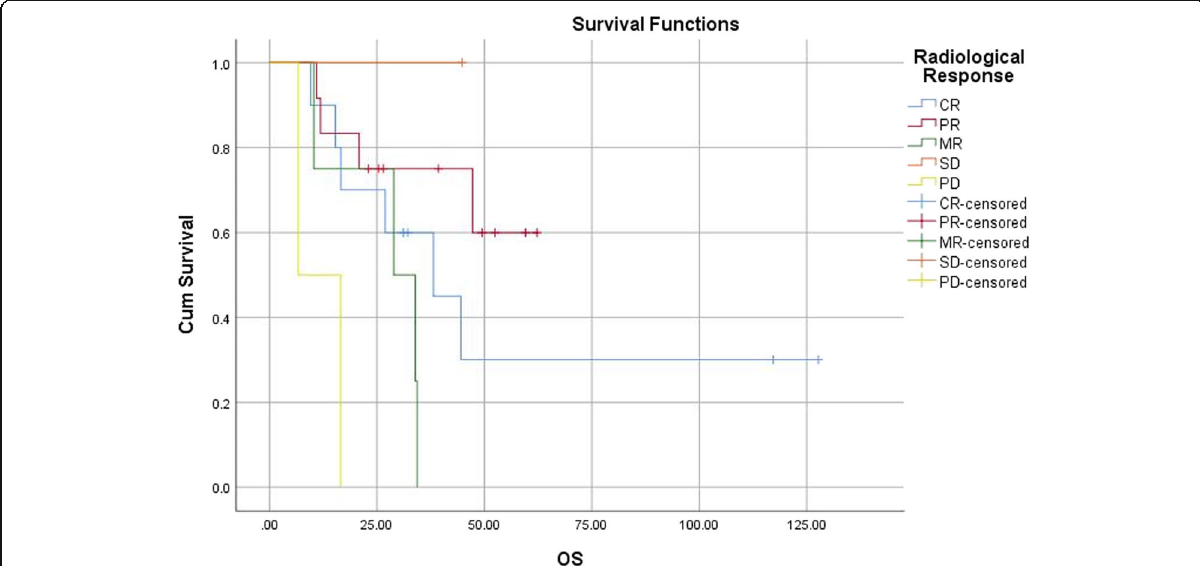
Fig. 4 Correlation between radiological response post-induction and overall